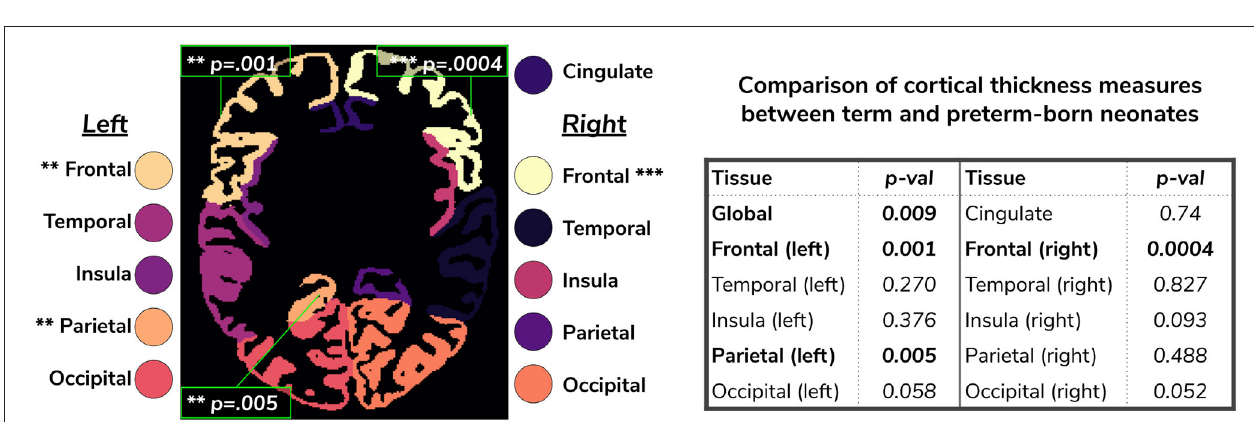
FIGURE 12 | Comparison of cortical thickness measures for the whole cortex and for each of the 11 cortical subregions between term and preterm-born neonates. The results of the linear regression are reported in the table in terms of differences between term and preterm-born neonates.